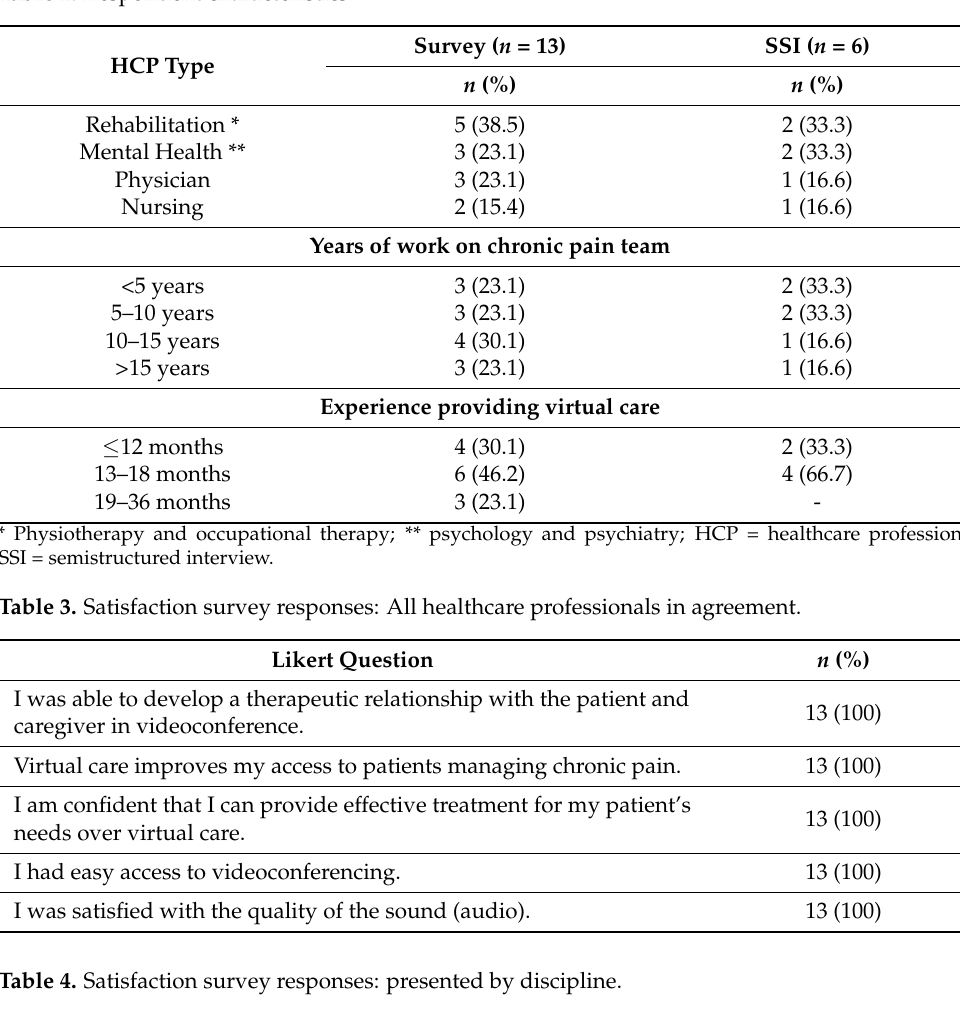
Table 2. Respondent characteristics.